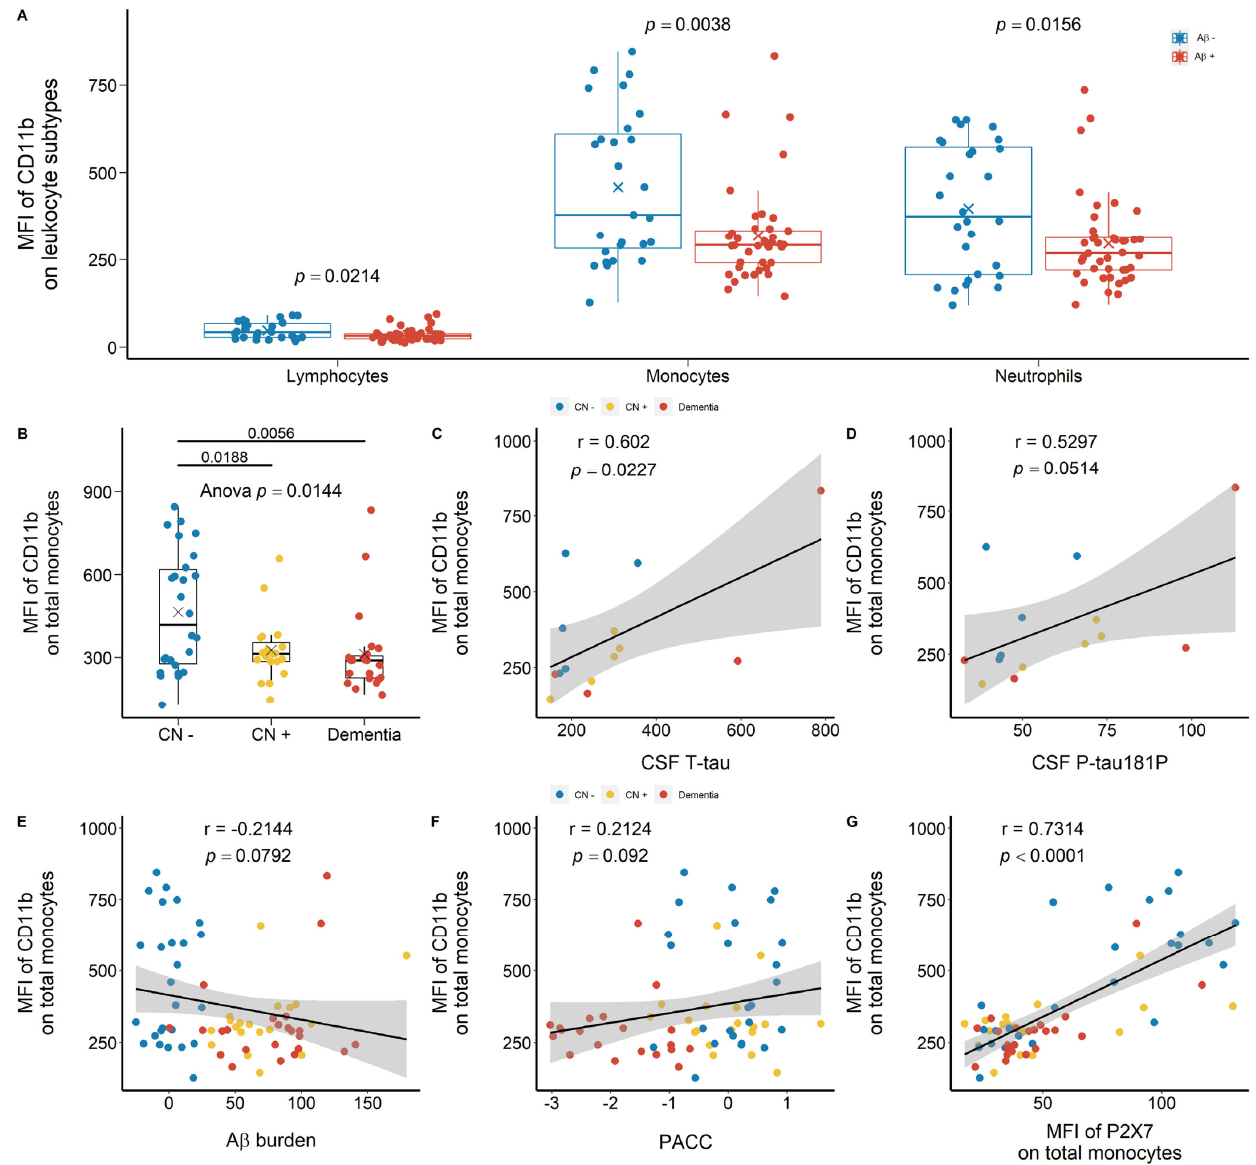
Figure 7. CD11b expressions on peripheral leukocytes in the discovery cohort. ( A ) CD11b expressions on total lymphocytes ( left ), total monocytes ( middle ), and total neutrophils ( right ) between Aβ −ve (Aβ−) and Aβ +ve (Aβ+). Bar graphs illustrated the boxplot distribution of individual measurements with “x” denoting the mean. Two group comparison was determined by t -test. ( B ) CD11b expressions on total monocytes between CN (CN−: CN −ve), pre-clinical (CN+: CN +ve), and AD with dementia (Dementia: MCI +ve and AD) individuals. Bar graphs illustrated the boxplot distribution of individual measurements with “x” denoting the mean. Three-group comparison was determined by one-way ANOVA followed by multiple comparison using Dunnett’s post-hoc test (solid line). ( C – F ) Associations between monocytic CD11b expressions, CSF biomarkers (μg/L), Aβ burden (CL) measured by PET, and PACC. ( G ) Association between leukocyte CD11b expressions and P2X7 expressions. Correlation r and p values were calculated by Pearson product-moment correlational analysis. The “grey” band indicated the 95% confidence interval of the black linear regression line.